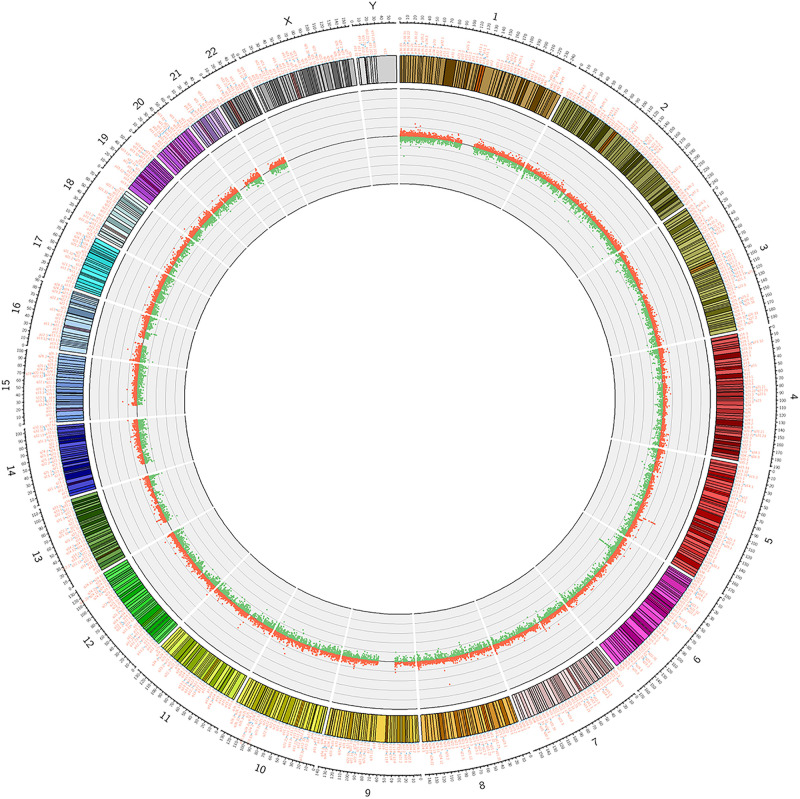
Circosplot for the whole genomic methylation patterns of the non-CR (n = 6) and CR (n = 6) patients. The hyper- and hypomethylation sites in 23 chromosomes (red dots: hypermethylation, green dots: hypomethylation).